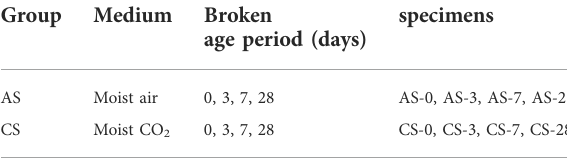
TABLE 2 Naming rules of the Self-healing test specimens.